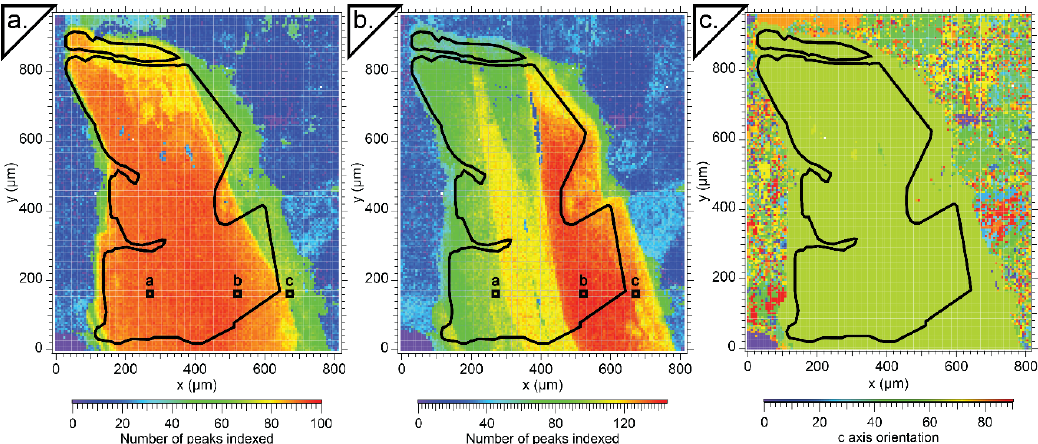
Figure 3. Grain can be indexed as both ( a ) 4H-SiC; and ( b ) 6H-SiC; ( c ) c-axis orientation with respect to the sample normal is also shown, to demonstrate the intergrowth of the two crystal types along the same stacking direction. The black outline indicates the surface expression of the sample, based on microscopy images. The squares labelled a, b, and c correspond to the diffraction pattern locations from Figure 4.